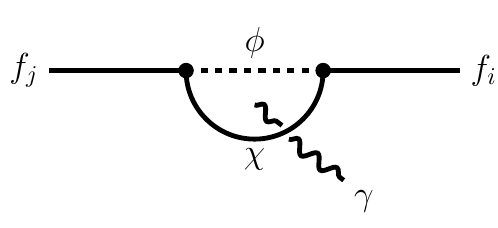
Figure 1 . The 1-loop diagram generating the dipole operator of eq. (2.3) from a generic UV theory with new heavy scalars ( φ ) and fermions ( χ ). We present the contribution of generic scalars and fermions in the loop in appendix A. The photon can be emitted from either of the particles running in the loop, provided that they are electrically